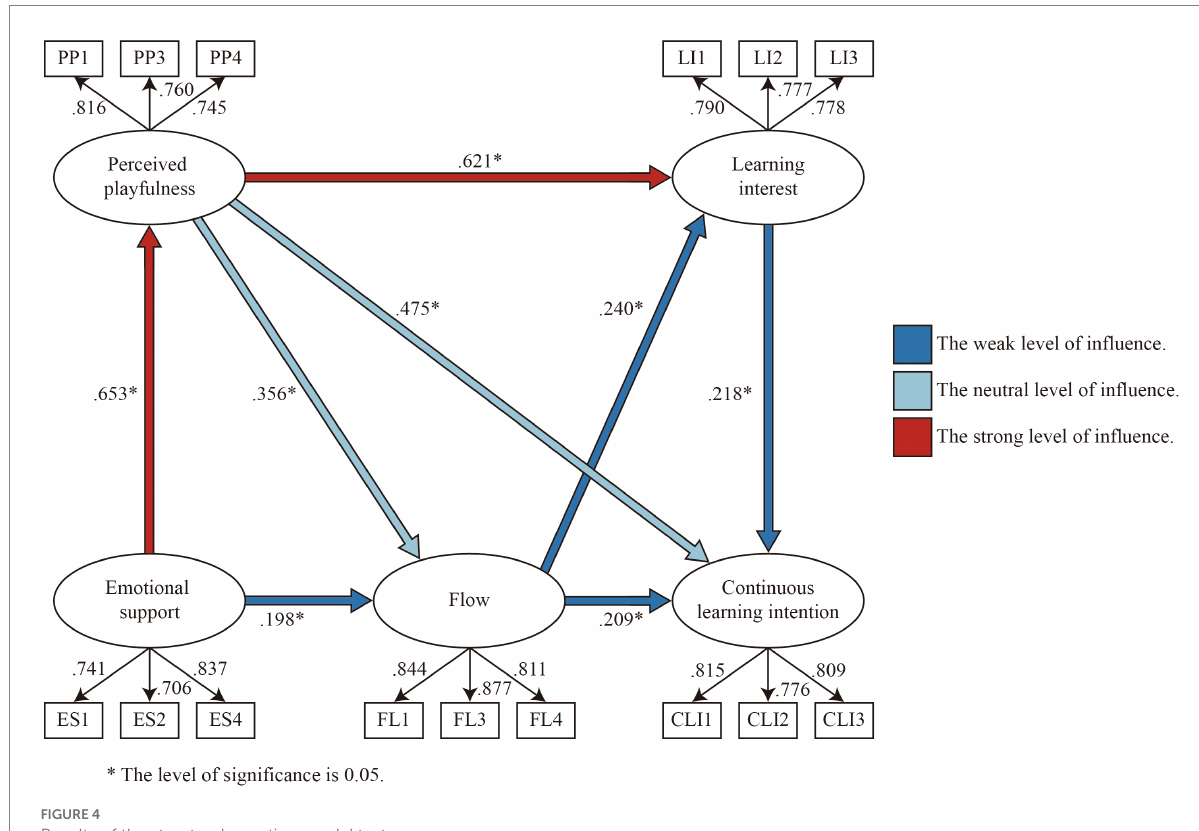
FIGURE 4 Results of the structural equation model test.